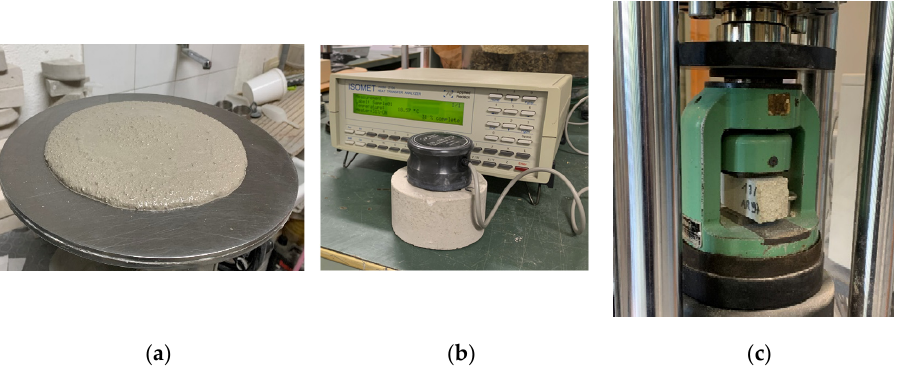
Figure 3. Characterization tests: ( a ) flow table test; ( b ) thermal conductivity test; ( c ) compressive test.